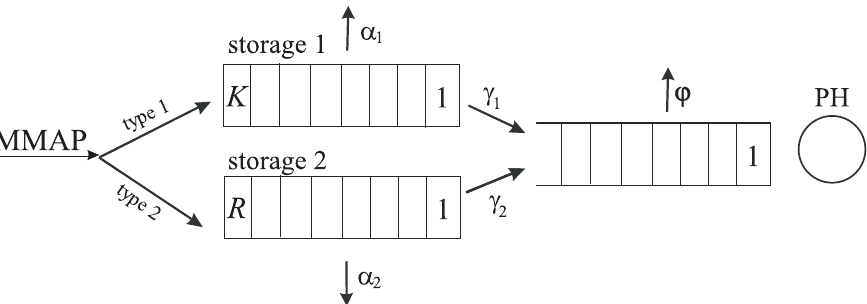
Figure 1. Queueing system under study. MMAP, Marked Markov Arrival Process; PH,